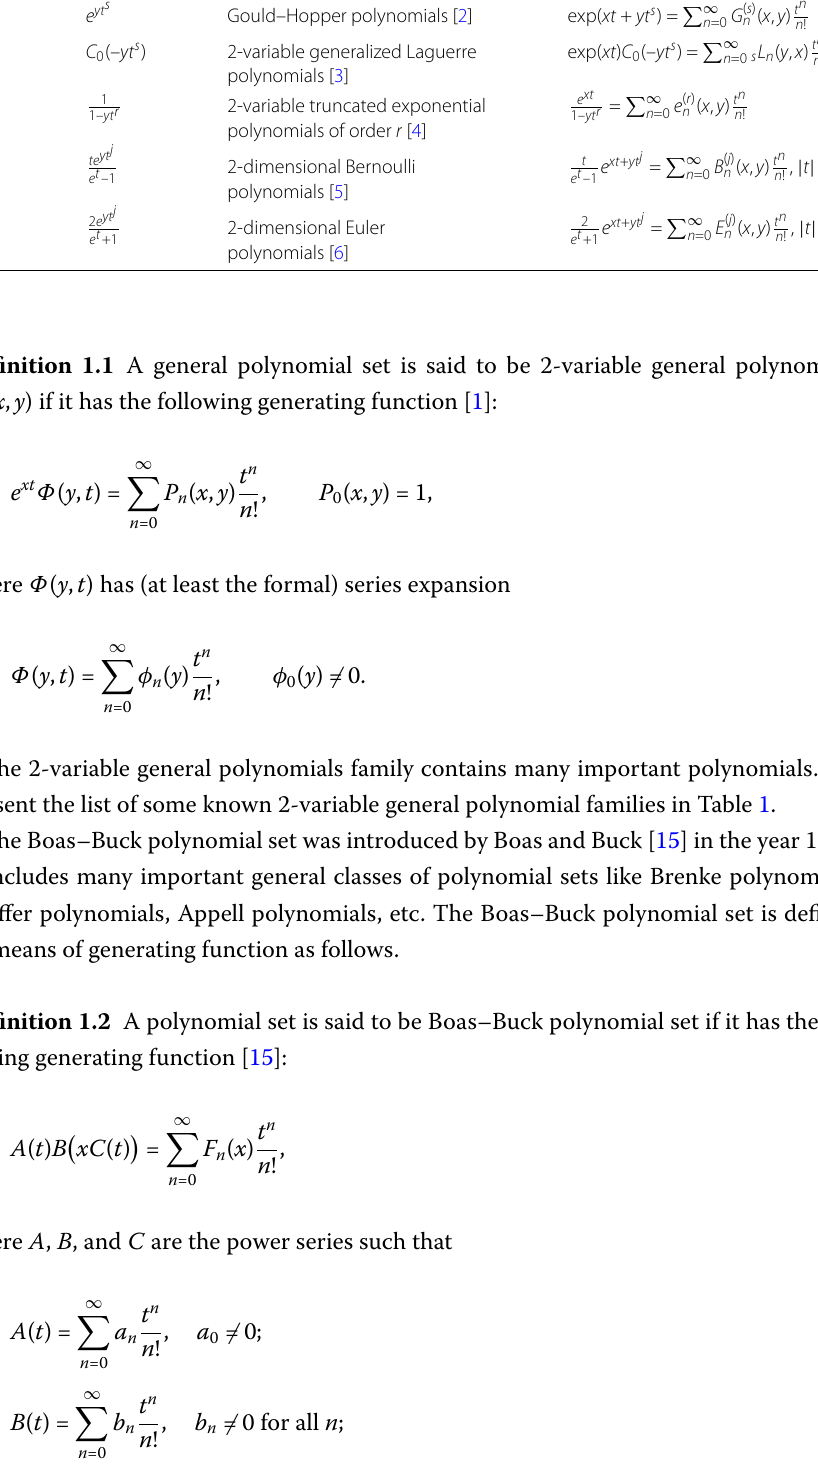
Table 1 Certain members belonging to the 2-variable general polynomials P n ( x , y ) S.